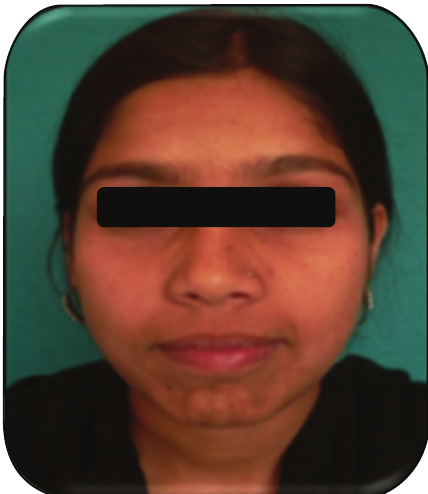
Figure 10: Postoperative photograph.